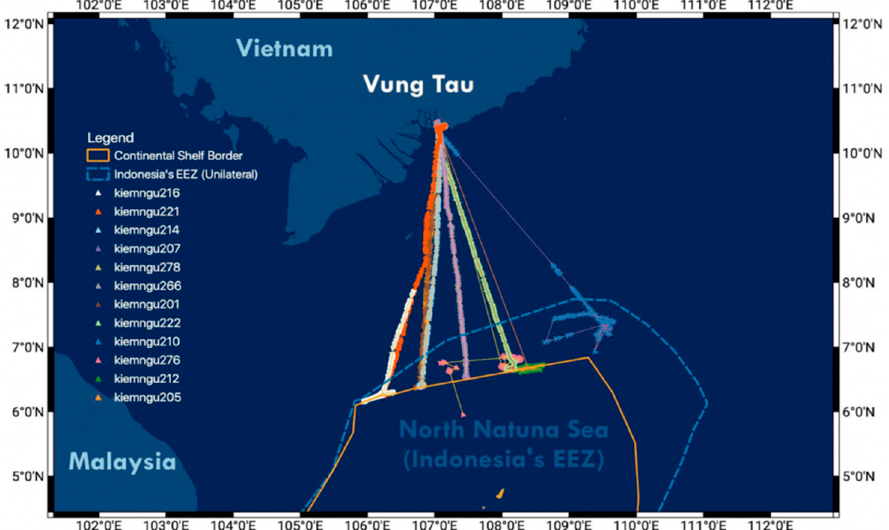
Figure 3. Track of VFRS between July and September 2022. Source: Indonesian Ocean Justice Initiative (IOJI